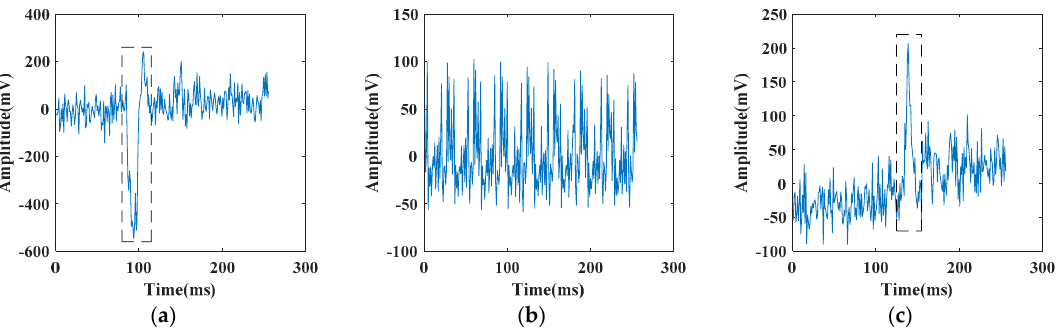
Figure 6. Fiber vibration signals in time domain: ( a ) pickaxe; ( b ) electric drill; ( c )